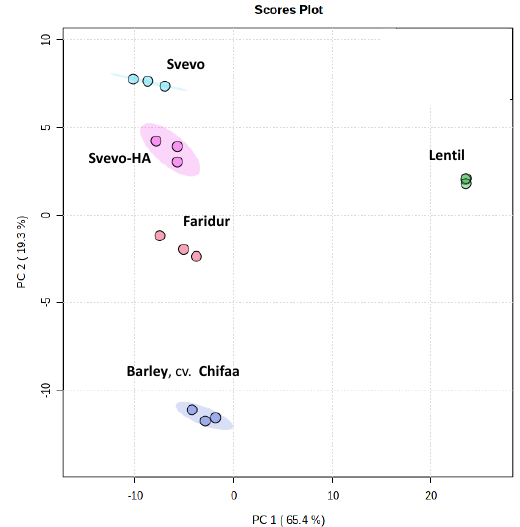
Figure 4. PCA model from the 600 MHz 1 H NMR spectra obtained for wheat, lentil and barley aqueous extracts.